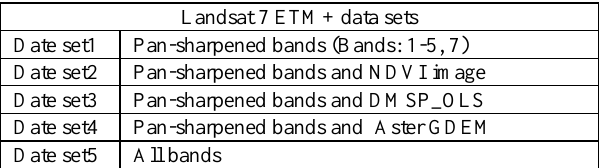
Table 1.The data sets showing band combination that used to